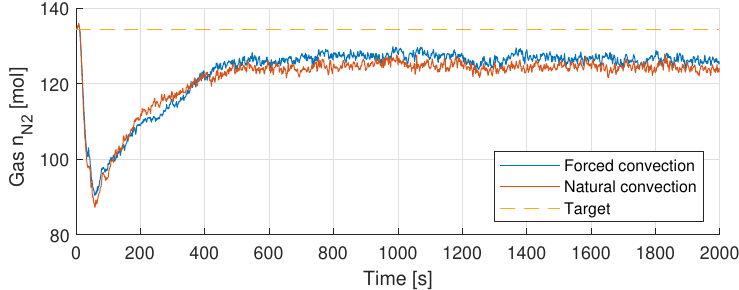
Figure 13. Estimated and experimental molar value for the low-load test sequence under natural and forced convection conditions. The accumulator is pre-charged to 125 bar/134